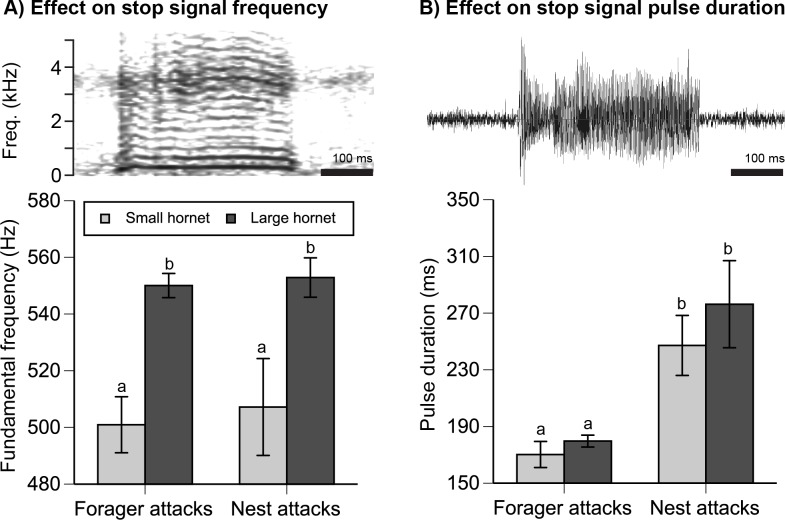
Effect of predator type upon stop signal vibrational characteristics (n = 282 bees from three colonies, analysis based upon the mean stop signal frequency and pulse duration per bee).(A) Large hornets elicited stop signals with a consistently higher fundamental frequency. The spectrogram shows a typical stop signal produced by a forager attacked by the large hornet. (B) Nest attacks elicited signals with a consistently longer pulse duration. The oscillogram shows a typical stop signal produced by a worker attacked by the hornet at the nest entrance. Graphs show the mean ± 1 standard error. Different letters indicate significant differences (Tukey’s HSD test, p < 0.05).